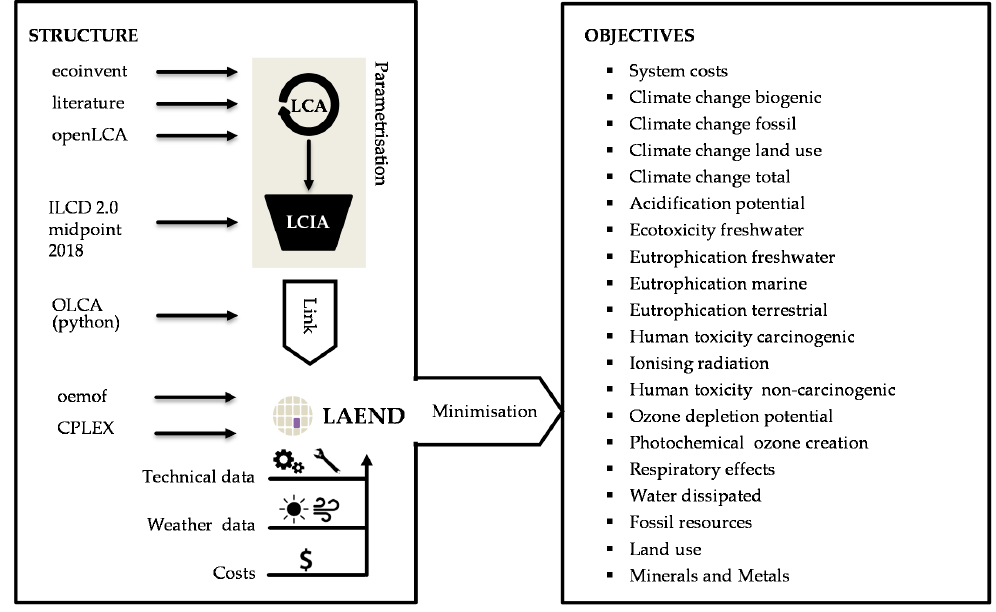
Figure 2. Structure and objectives of the model LAEND. Source: authors’ illustration (icons from [30]).